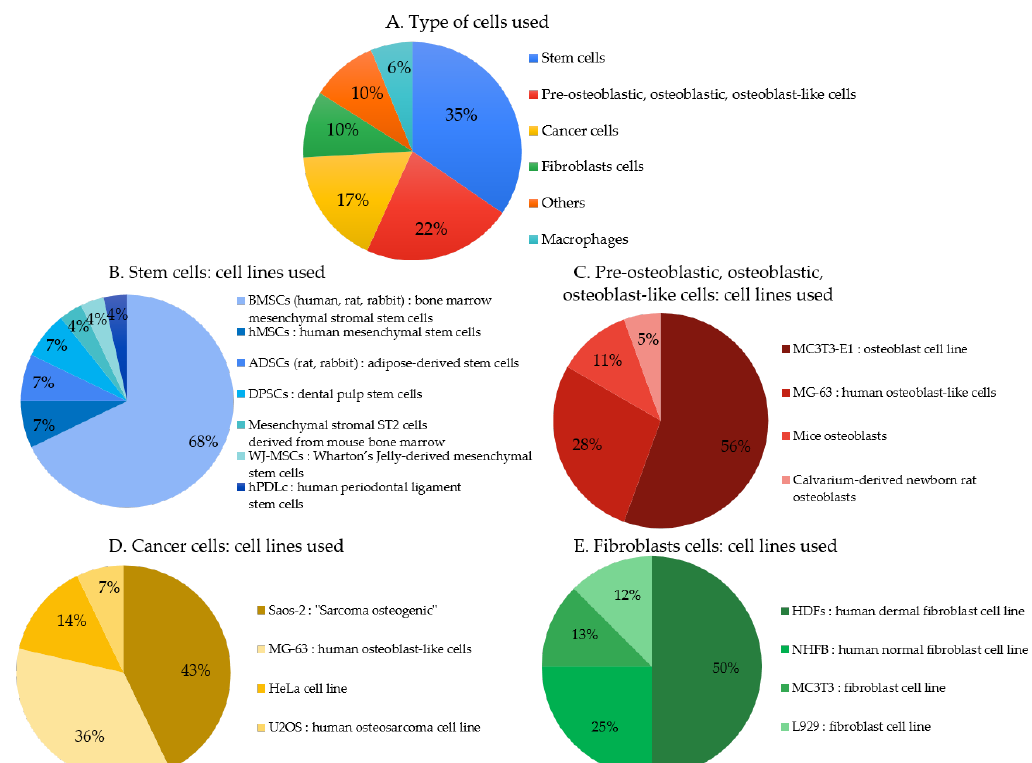
Figure 6. ( A – E ). Primary cells and cell lines used to assess cytocompatibility in the studied